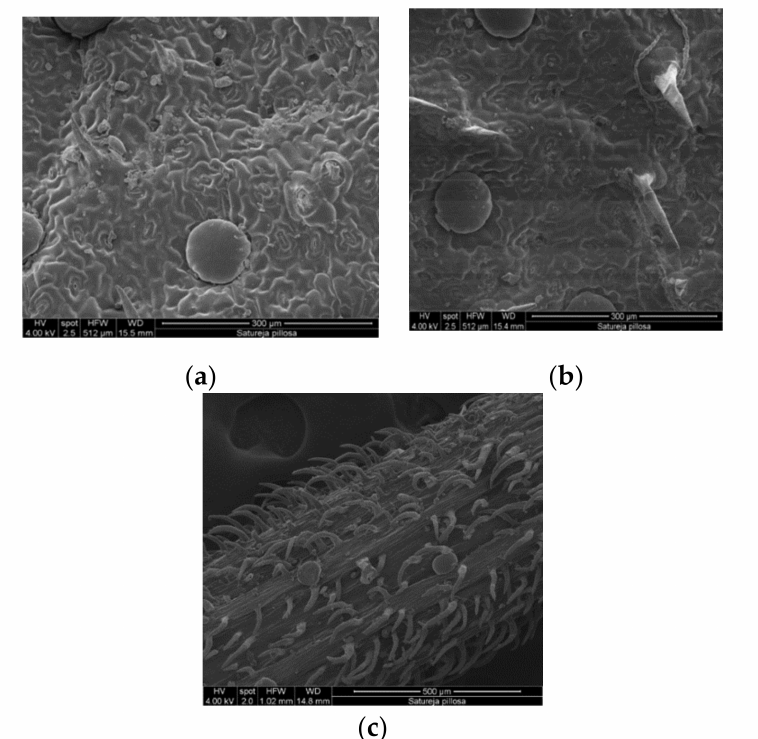
Figure 3. Scanning Electron Microscopy (SEM) analysis of Satureja pilosa L. leaf surfaces; adaxial ( a ) and abaxial ( b ) epidermis. Essential oil sessile glands are visible on both the adaxial and abaxial surfaces and also on the petiolate ( c ).